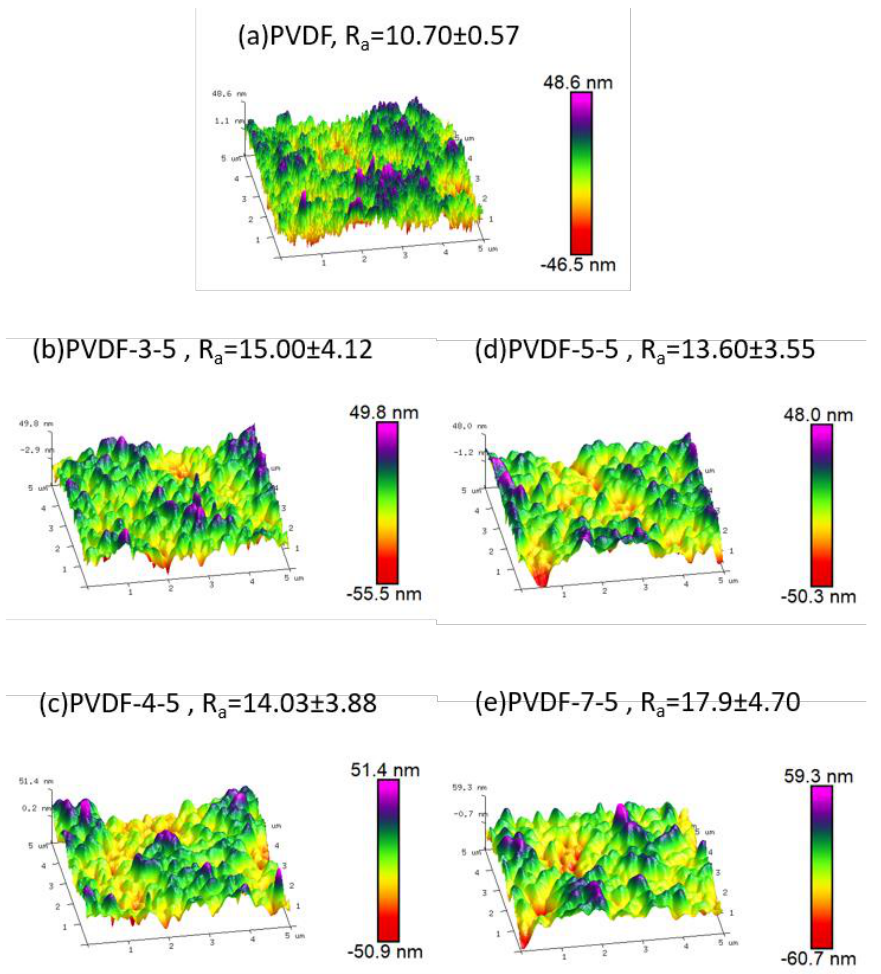
Figure 2. Three-dimensional (3D) AFM images of the loose NF membrane. ( a ) PVDF, ( b ) PVDF-3-5, ( c ) PVDF-4-5, ( d ) PVDF-5-5, and ( e ) PVDF-7-5. Scan size: 5 × 5 µm 2 . R a represents the average of surface roughness.